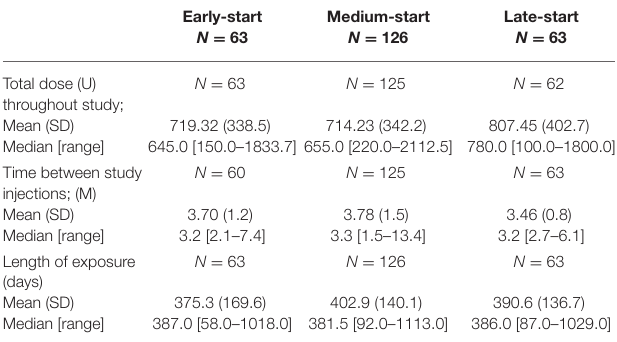
TABLE 1 | Baseline (Visit 1) characteristics. TABLE 2 | AbobotulinumtoxinA